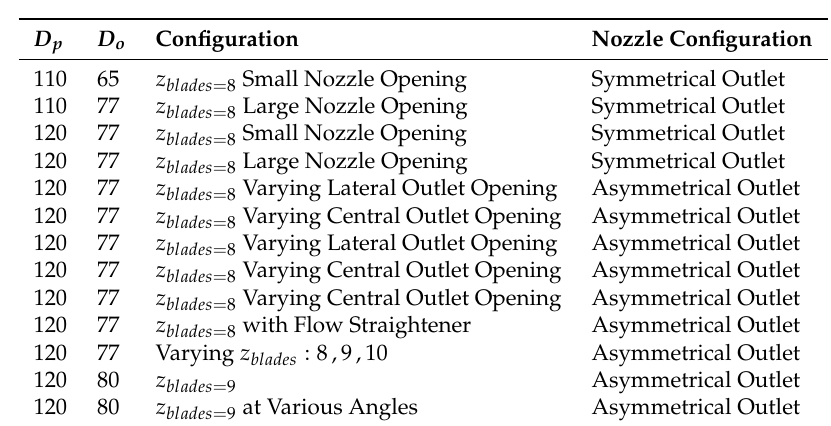
Figure 16. Examples of different configurations tested. Table 3.